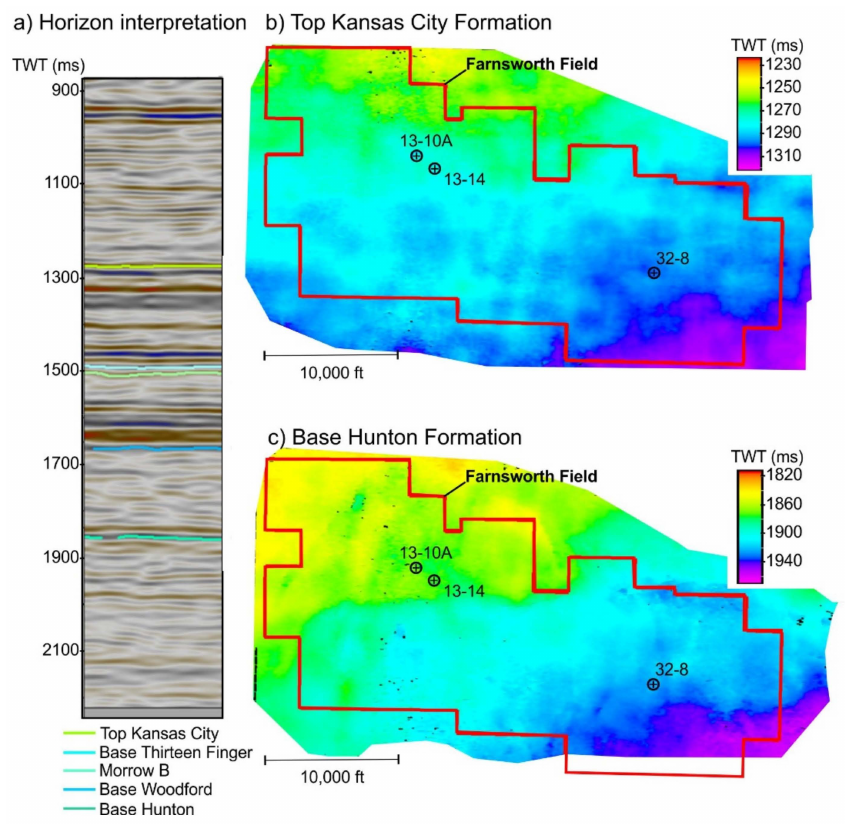
Figure 5. Interpreted horizons at location of well 13-10A ( a ); Top Kansas City Formation ( b ); and Base Hunton Formation ( c ). Farnsworth Field is outlined in red; also shown are locations of wells 13-10A, 13-14, and 32-8. Based on well ties, the “Morrow B reflector” is located within the Morrow